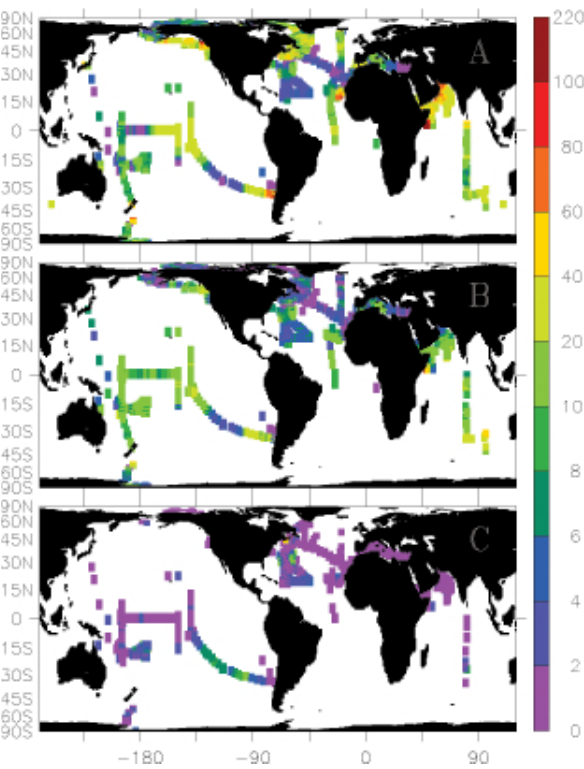
Figure 6. Zonal and time-averaged biomass [ µ gCl − 1 ] of (A) Prochlorococcus , (B) Synechococcus , (C) picoeukaryotes. Data have been filled by latitudinal interpolation of up to 22 ◦